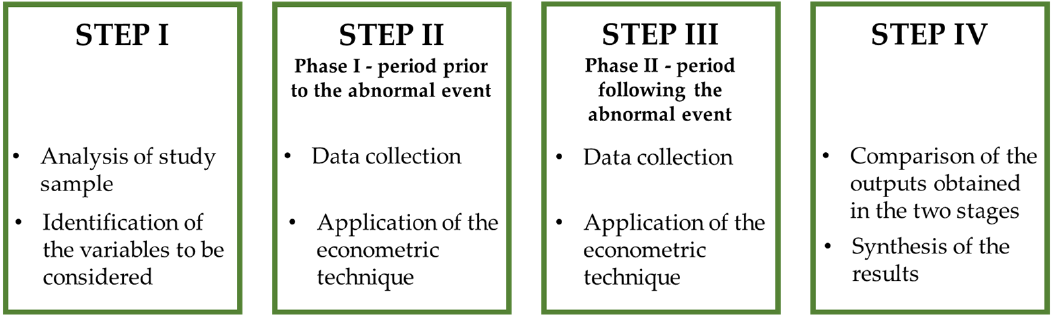
Figure 1. Summary of the main steps of the methodology for the assessment of the effects of anomalous events on housing market.